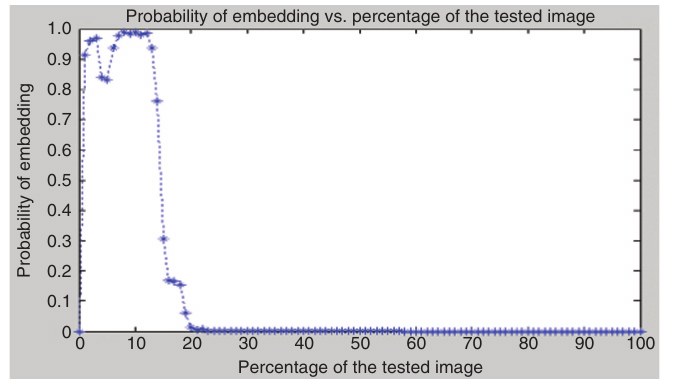
Figure 4. Results for χ 2 Attack on Man Stego-image That Has Been Embedded by the Proposed Method Using 5-Pixel Group and Tested on 100,000 Bits of the Secret Message.